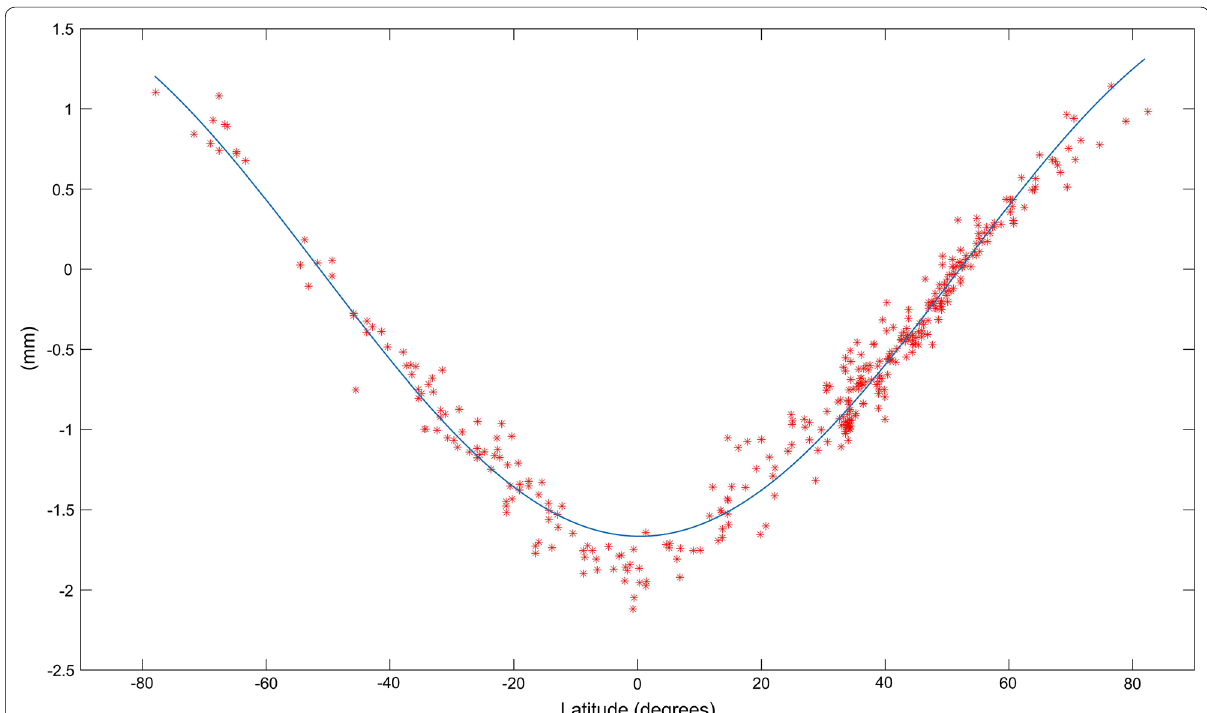
Fig. 4 Station height error versus latitude due to the hydrostatic mapping function for the GPS DDA stations ( y = 1.665sin ( 0.03038 x − 1.582 ) )